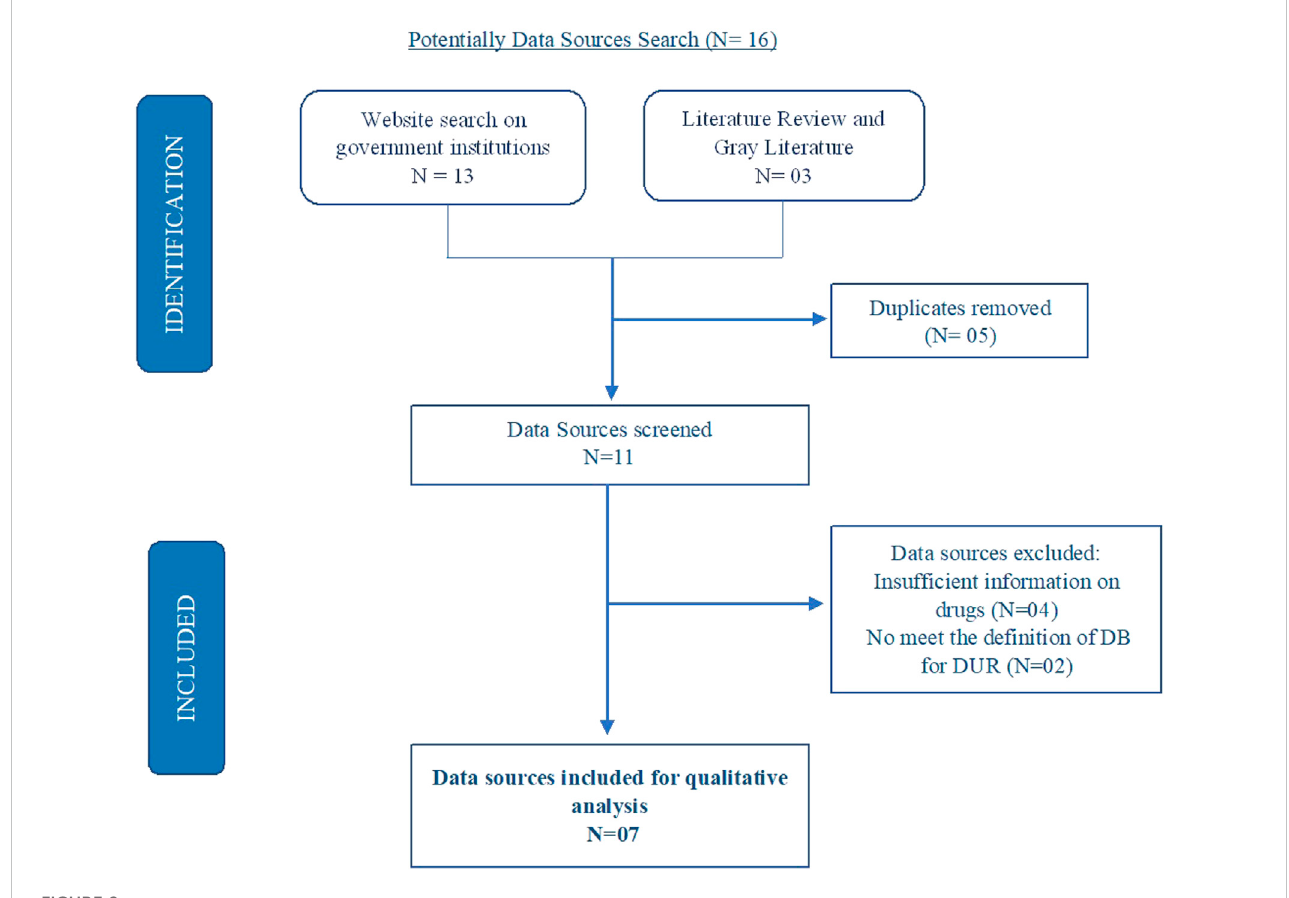
FIGURE 2 Drug data sources search fl owchart. Potentially Data Sources Search ( N =